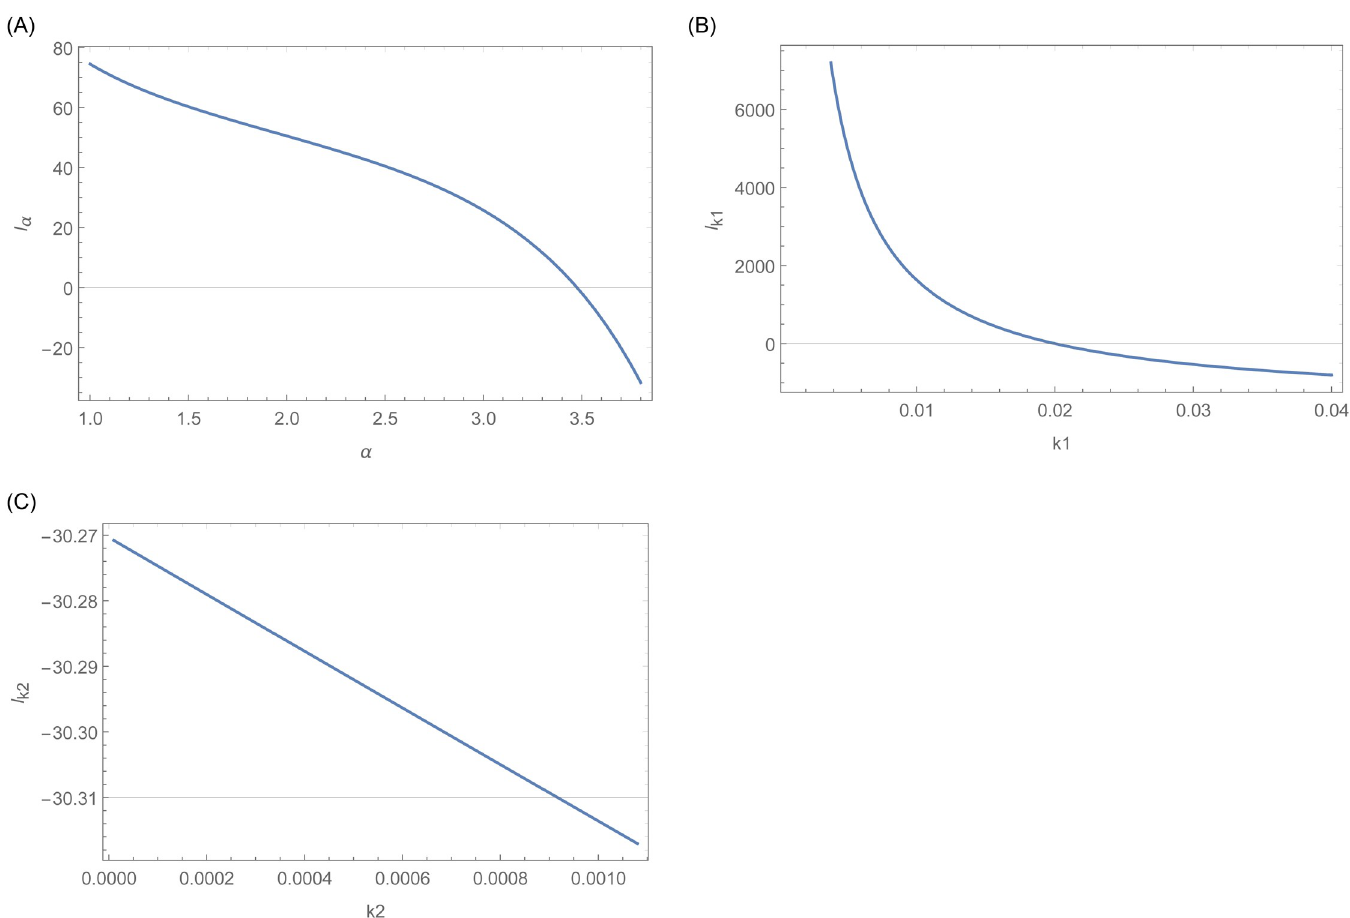
Fig 19. This figure indicates the existences of the log likelihood function as each curve intersect the x-axis at one point for the second data